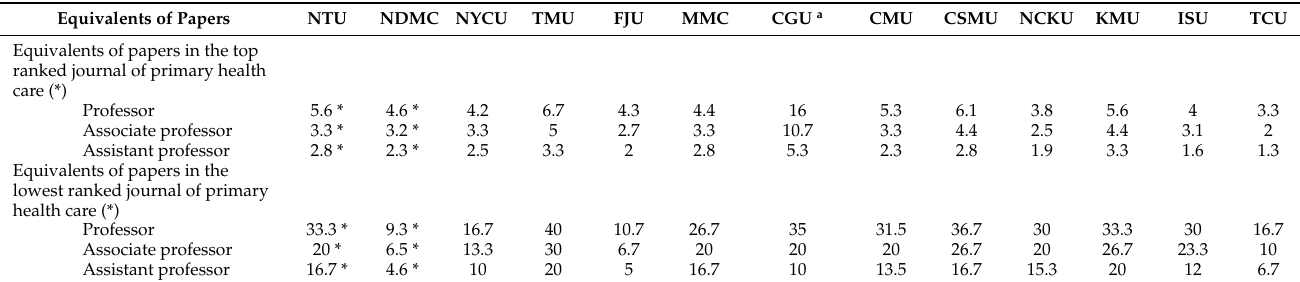
Table 4. Comparison of the academic promotion scoring system based on the numbers of papers equivalent to different thresholds among 13 medical schools in Taiwan.